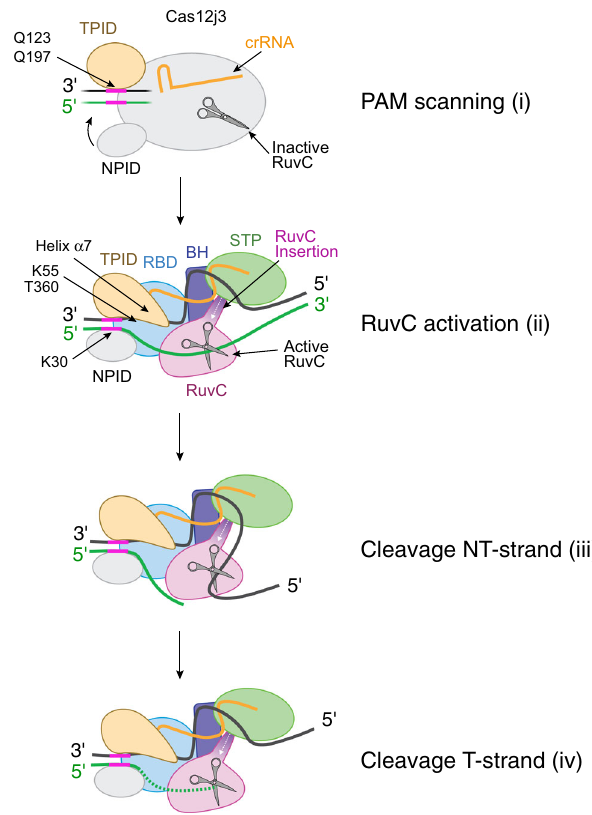
Fig. 7 Model of Cas12j3 PAM-dependent DNA recognition, unwinding and cleavage. Cartoon model depicting the stages of Cas12j3 nuclease staggered target DNA cleavage (see Discussion). The T-strand and NT-strand are illustrated in green and black, with the PAM colored in pink. In step (i) the RBD, BH, STP, and RuvC domains are represented as an oval (see